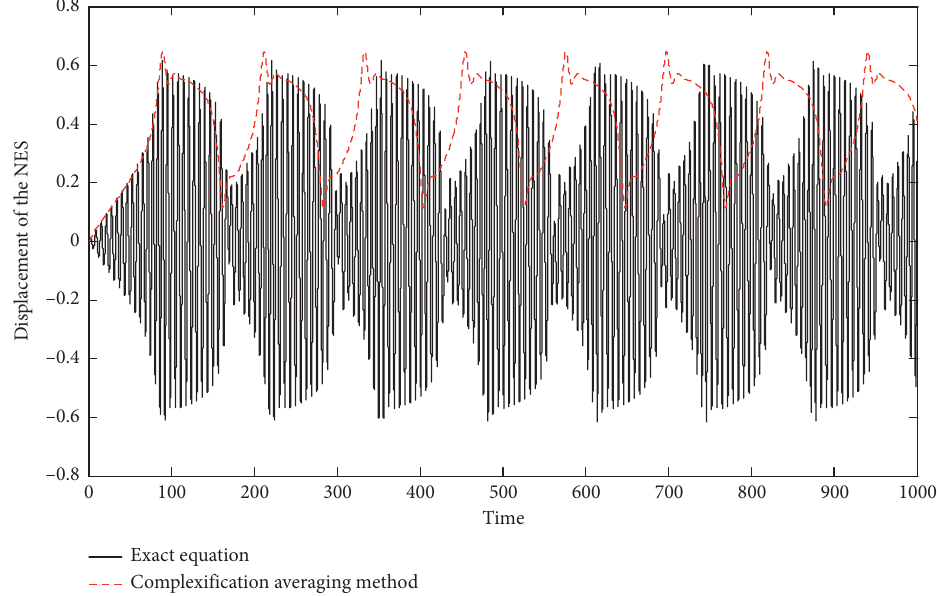
� 0 . 8 ; λ � 0 . 3 ; kn � 5 ; f � 0 . 5. 1 2